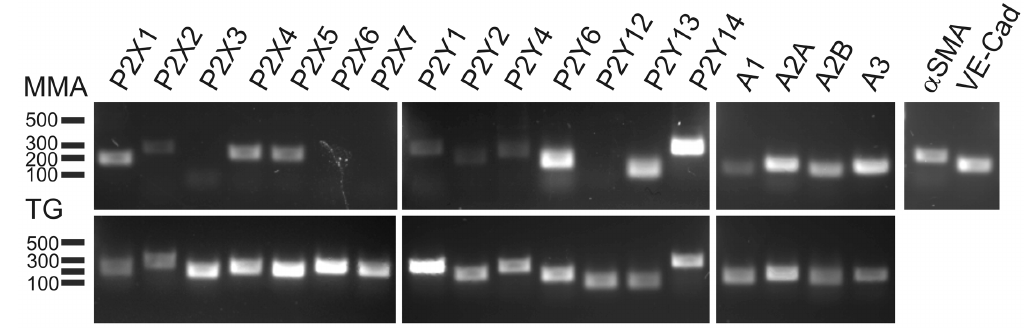
Figure 7. RT-PCR of purinergic receptors in MMA. The top lane is a representative RT-PCR for 3 different runs (each consisting of 6 pooled MMA). The lower lane is a control for all primers run on trigeminal ganglion mRNA. All bands have the correct expected size, see table 1. a SMA ( a Smooth Muscle Actin) and VE-Cad (Vascular Endothelial - Cadherin) were used as controls.